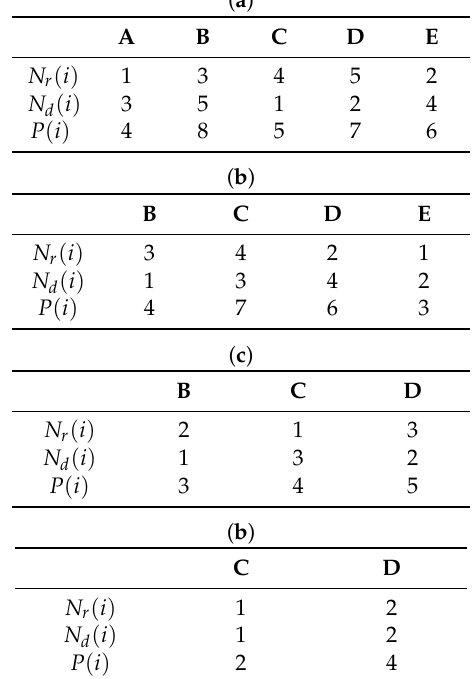
Figure 2. Charging path construction process. ( a )–( d ) The node with the smallest weight is chosen as the next charging node to build the virtual charging path successfully. ( e ) The fifth charging node selection and virtual path construction failure. ( f ) MC returns to the starting point for energy replenishment of and prepares for the next round of charging. Table 2. Node weight change process.